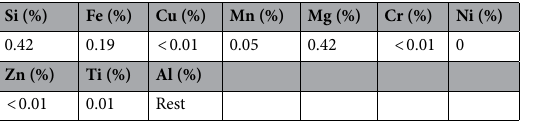
Table 1. Chemical composition of the EN AW 6060 T66 aluminous alloy.